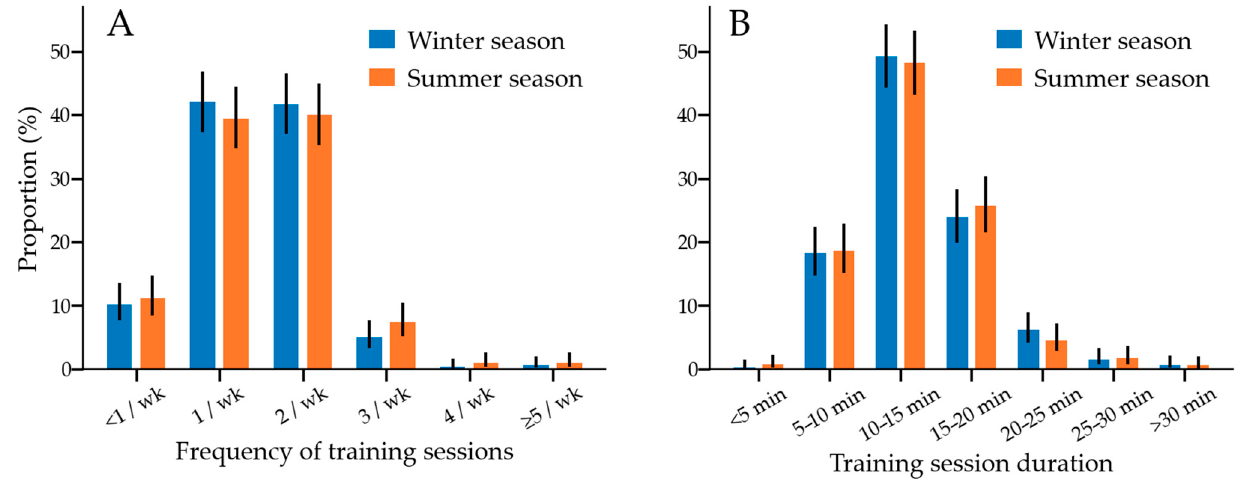
Figure 3. ( A ) Frequency of training sessions during winter ( n = 734) and summer ( n = 703) seasons.